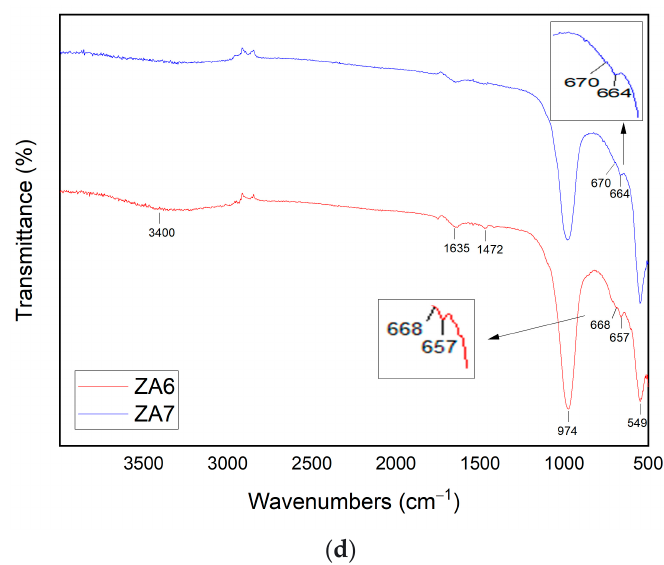
Figure 6. XRD pa tt erns of synthesized zeolites ZA6 and ZA7 (( a ), * sodalite and ° LTA). SEM micro- Figure 6. XRD patterns of synthesized zeolites ZA6 and ZA7 (( a ), * sodalite and ◦ LTA). SEM graphs of ( b ) ZA6 and ( c ) ZA7. FTIR spectra for ZA6 and ZA7 ( d ). micrographs of ( b ) ZA6 and ( c ) ZA7. FTIR spectra for ZA6 and ZA7 ( d